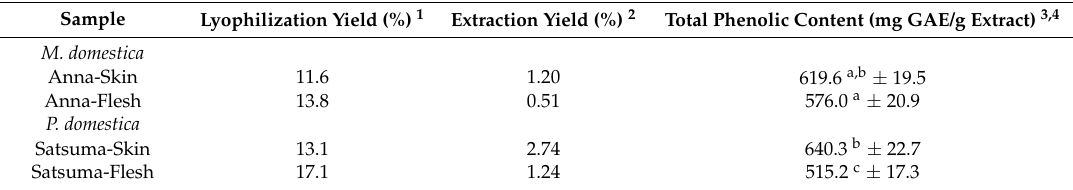
Table 1. Extraction yield and total phenolic